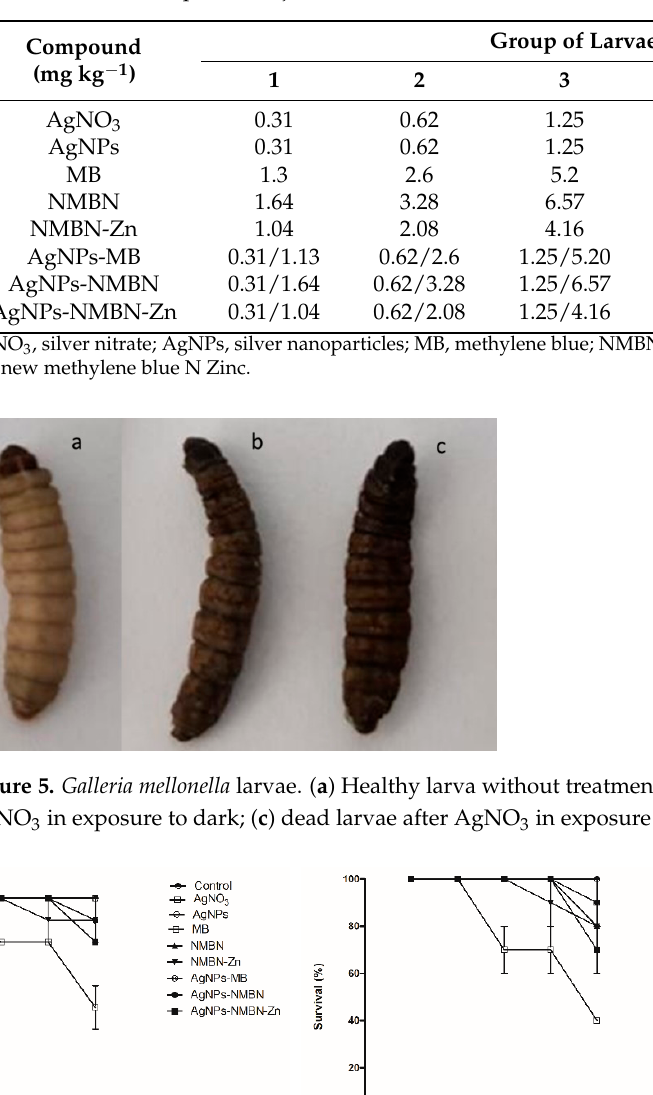
Table 5. Doses of compounds injected in Galleria mellonella . Compound